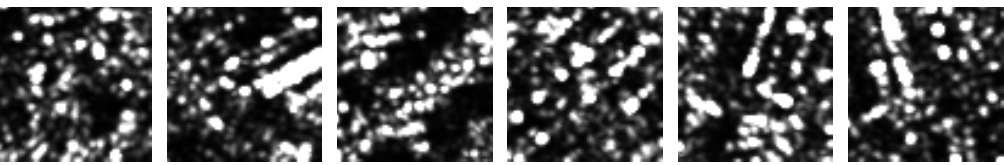
Figure 1. High intra-class diversity of SAR images. These six images come from a high-density residential area. Although they share the same class, i.e., the high-density residential area, they present random and ever-changing spatial patterns.